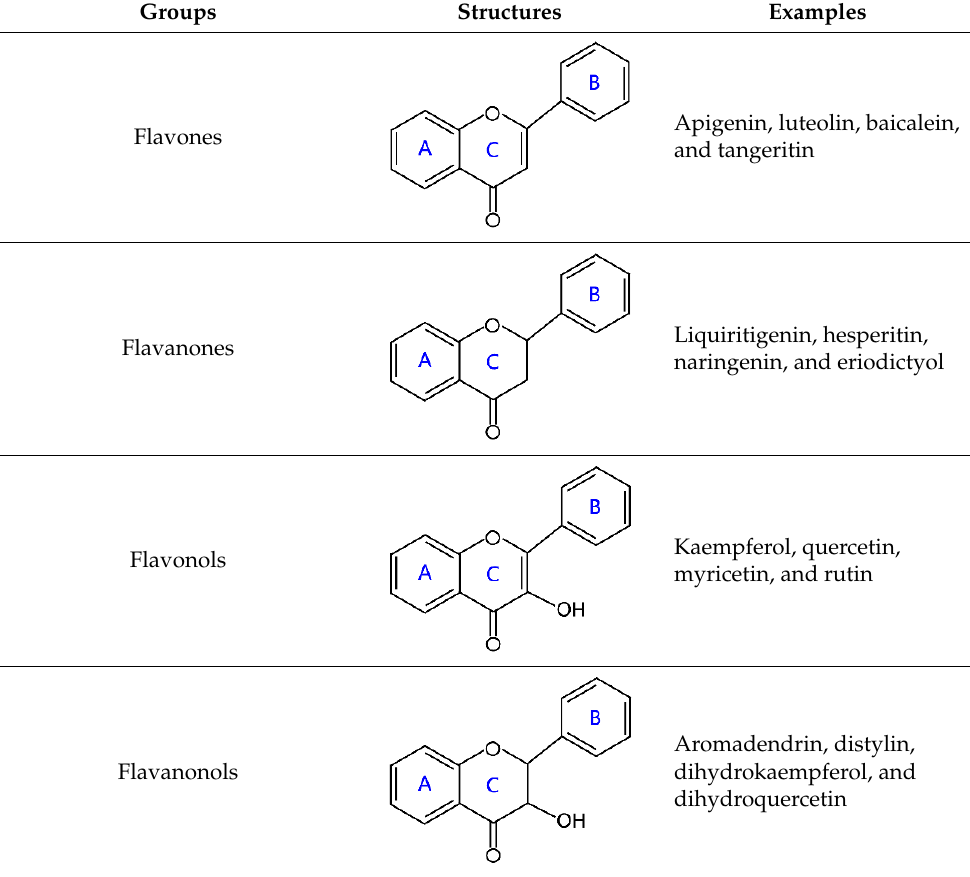
Table 1. Structural features and classification of flavonoids. Groups